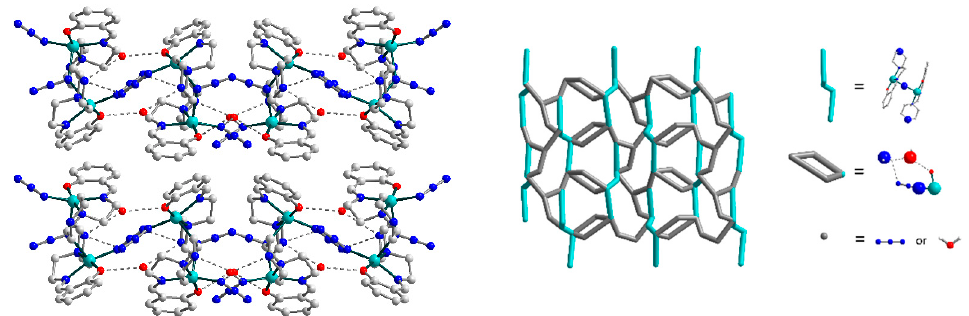
Figure 4. Packing of the supramolecular layers in 1 along the a axis. The hydrogen atoms are omitted for clarity. Colour scheme: Cu, cyan; O, red; N, blue; C, grey. Right: simplified topology of the layer in 1 .